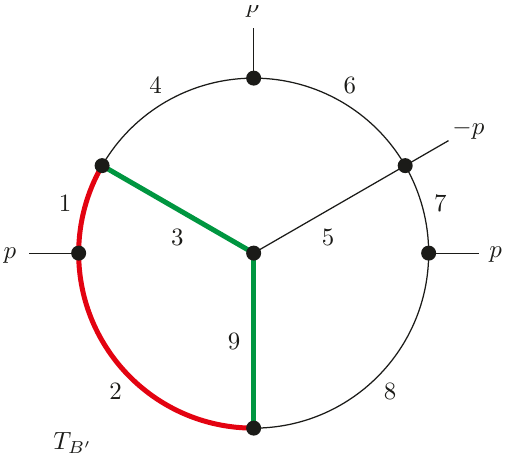
Figure 4 . The topology B 0 . This topology is related by the exchange m W ↔ m t to topology B . For the sectors B 0 and B 0 we encounter the set of square roots ( r 255 479 the sector B 0 we encounter the set of square roots ( r 509